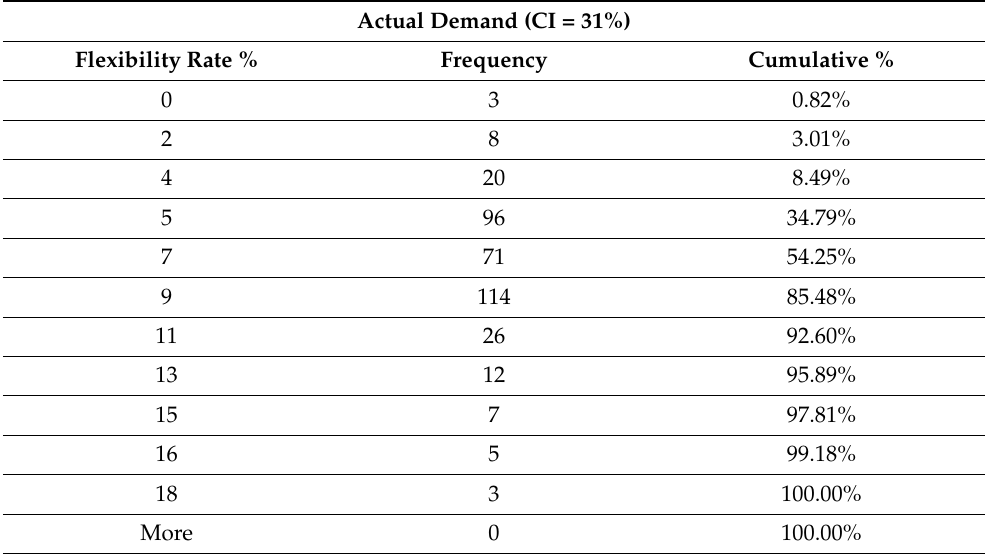
Table 10. The empirical results of flexibility rate from simulating Model 1.